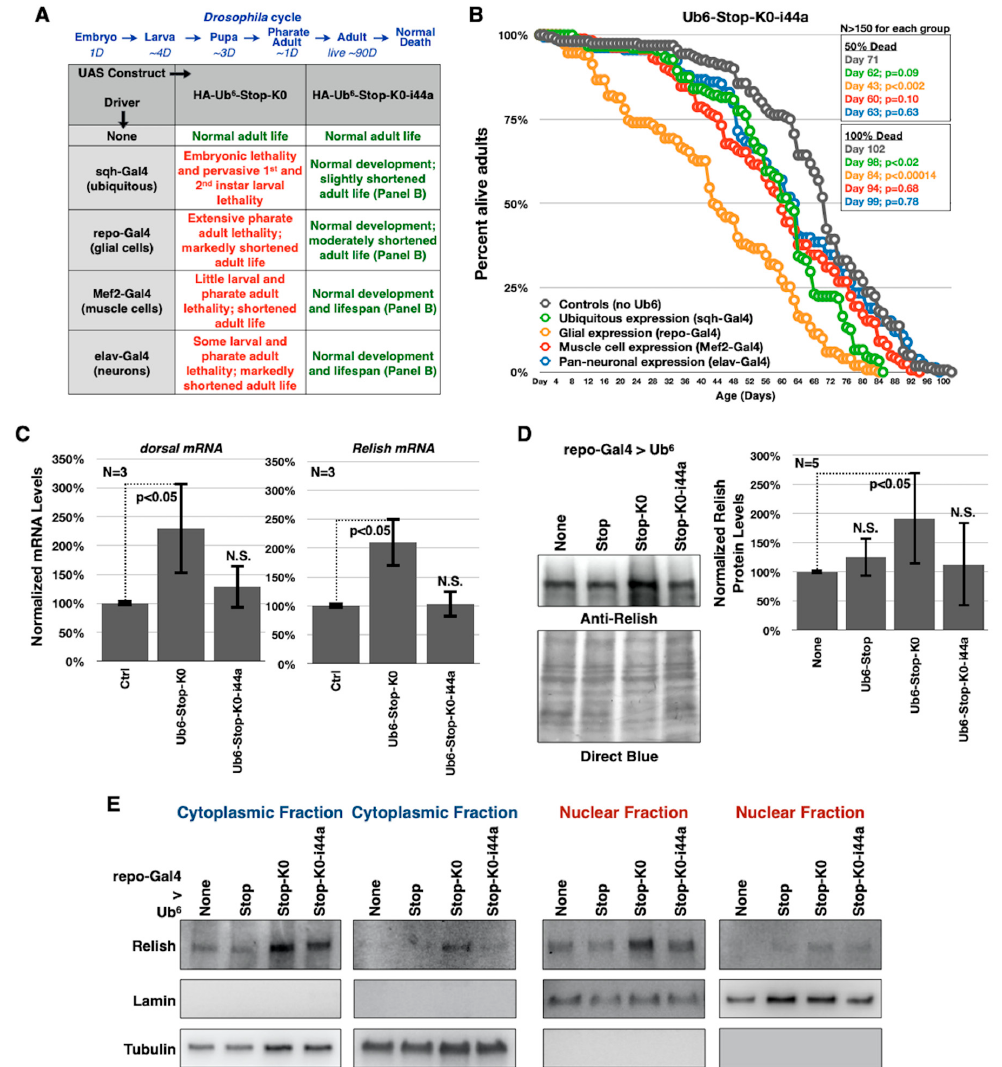
Figure 6. Isoleucine 44 mediates toxicity from free, linear, lysine-less ubiquitin chains. ( A ) Summary of findings when the noted transgenes are expressed as described. “None” denotes no Gal4 driver was present. Results are from crosses that were conducted simultaneously. ( B ) Longevity assays of adult flies expressing Ub 6 chains under the noted Gal4 drivers. “Ctrls” do not contain Ub 6 transgenes, but have the Gal4 driver on the genetic background that we utilized to generate the Ub 6 chain-containing flies. ‘ p ’ values are from log-rank tests. ( C ) mRNA levels of the noted NF-kB-related genes by qRT-PCR in dissected heads of pharate adults expressing Ub 6 -Stop-K0 or Ub 6 -Stop-K0-i44a in glial cells, presented as fold change over controls without the Ub 6 transgene. ‘ p ’ values are from Student’s t -tests comparing Ub 6 -expressing flies to controls. ( D ) Western blots from dissected pharate adult heads expressing the noted transgenes in all glial cells (left). Relish protein levels were normalized to direct blue and quantified (right). ‘ p ’ value is from Student’s t -tests comparing Ub 6 -expressing flies to controls that contain the driver on the same genetic background as ubiquitin chain-encoding flies. ( E ) Western blots from two independent cytoplasmic / nuclear fractionations of dissected pharate adult heads expressing, or not, Ub 6 transgenes in glial cells. In ( C , D ), “N.S.” denotes no statistical significance comparing a specific Ub 6 group to its respective control. Due to the temporary closure of our institution as a result of the COVID-19 pandemic, we were unable to obtain additional, independent samples for panel ( E ). We also encountered some di ffi culties with signal-to-noise ratio from the anti-Relish antibody for panel ( E ), but were unable to procure more reagents as a result of university